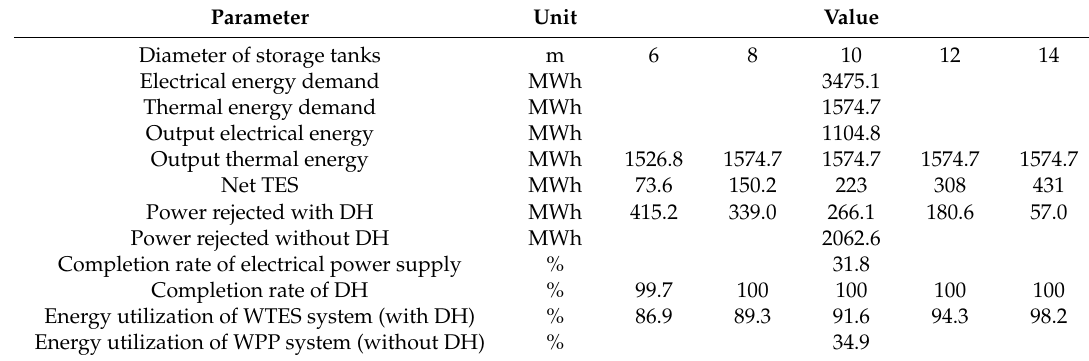
Table 4. Performance evolutions with various electrical energy demand and various storage tank